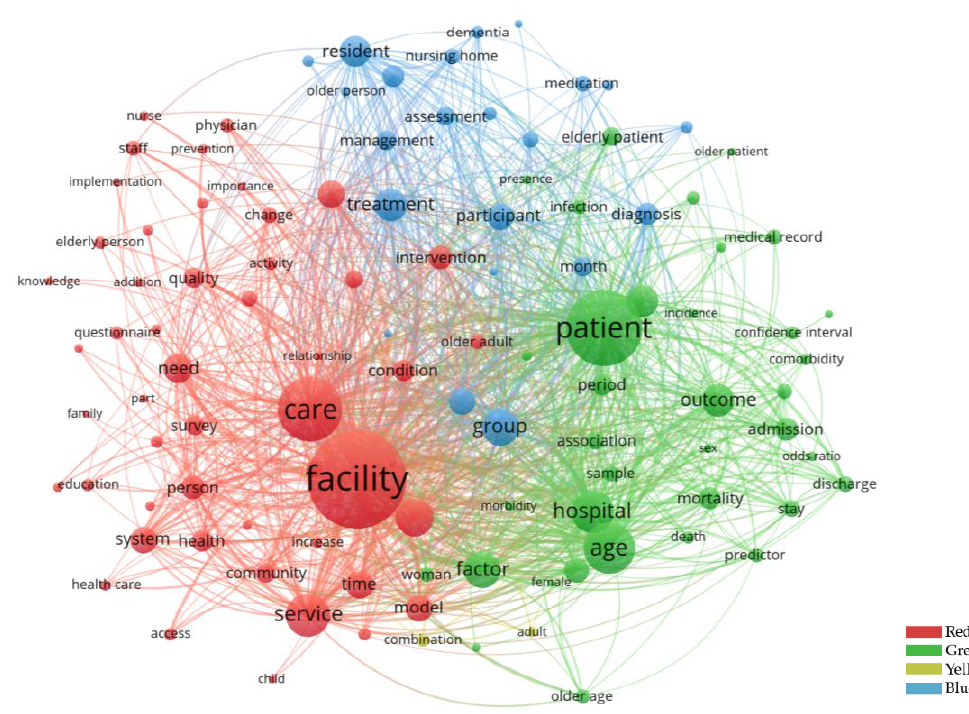
Figure 9. FCMNCE research keyword co-occurrence network map.